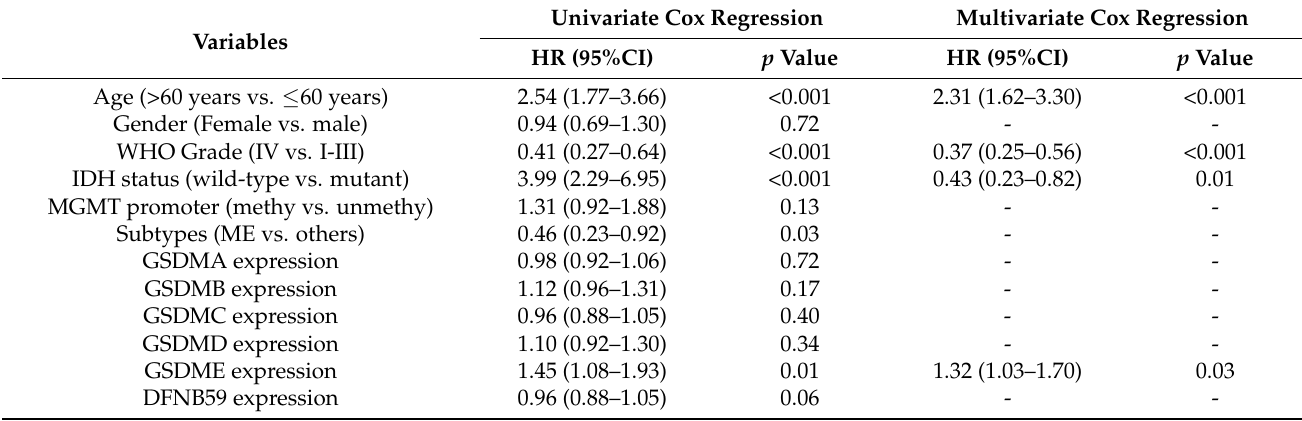
Table 1. Univariate analysis and multivariate COX analysis of clinical prognostic parameters of all glioma in the TCGA dataset.